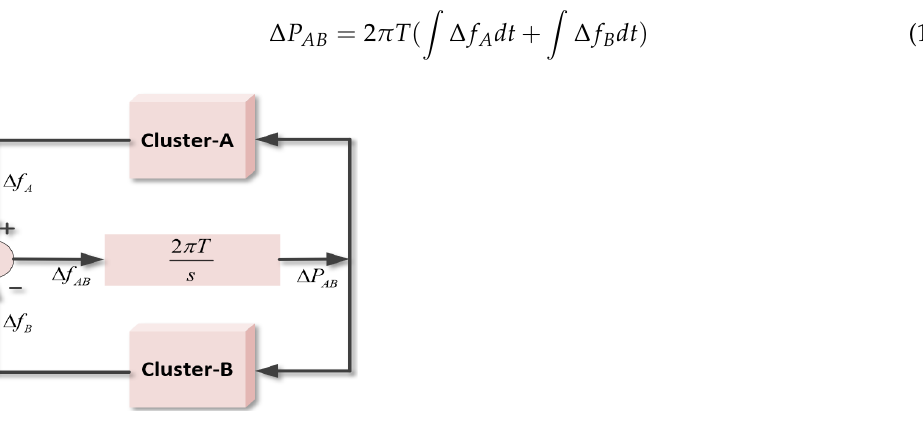
Figure 2. Tie-line modeling for microgrid clusters.